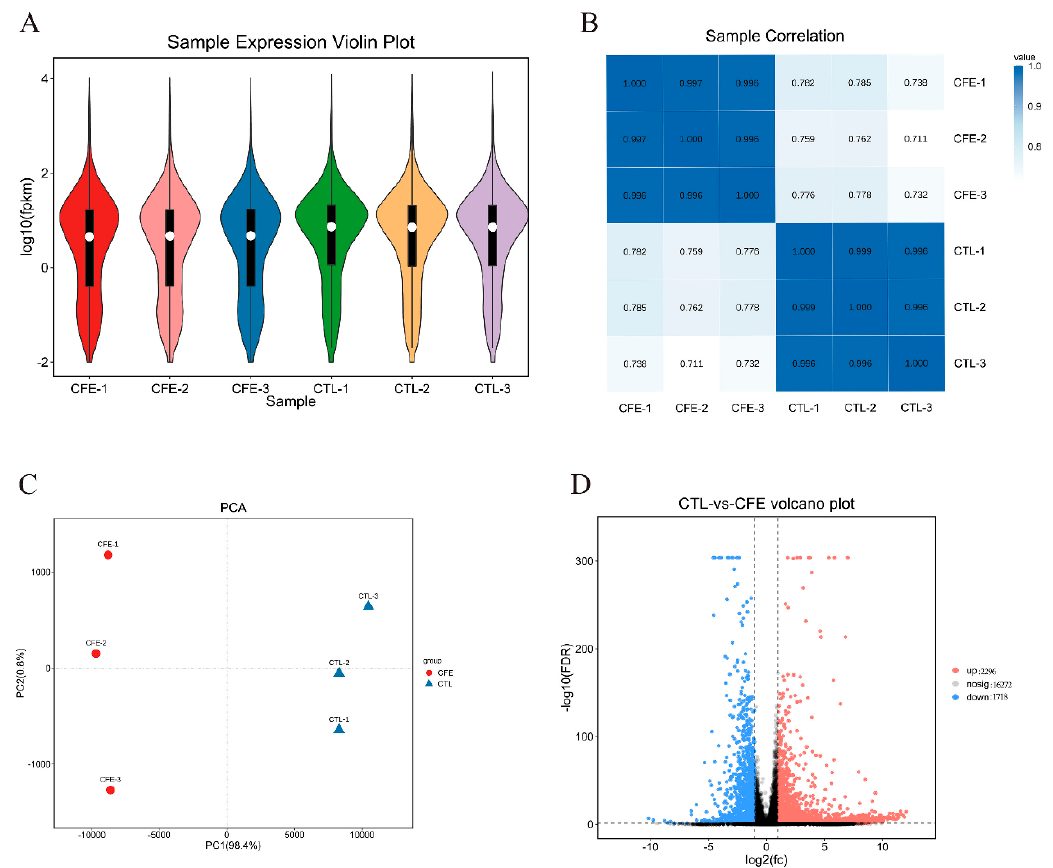
Figure 3. Effects of the cell − free extracts (CFEs) collected from L. plantarum YE4 (YE4 − CFE) on the global gene expression profiling in Caco − 2 cells. ( A ) Violin plot. The white dot in the plot represents the median, and the black rectangle is the range from the lower quartile to the upper quartile. The black line running through the violin represents the minimum non − abnormal value to the maximum non-abnormal value. ( B ) Sample correlation heat map. The value in each small box is the Pearson correlation coefficient (R). ( C ) Principal component analysis (PCA). PC1 represents the first principal component and PC2 represents the second principal component. ( D ) Volcano map. The red dots indicate the upregulated differentially expressed genes (DEGs). The blue dots indicate the downregulated DEGs. However, there is no significant difference in the expression of the genes in black. DEGs were estimated by FDR < 0.05 and |log2(FC)| > 1. CFE, treatment group after YE4 − CFE interacted with Caco − 2 cells; CTL, control group.